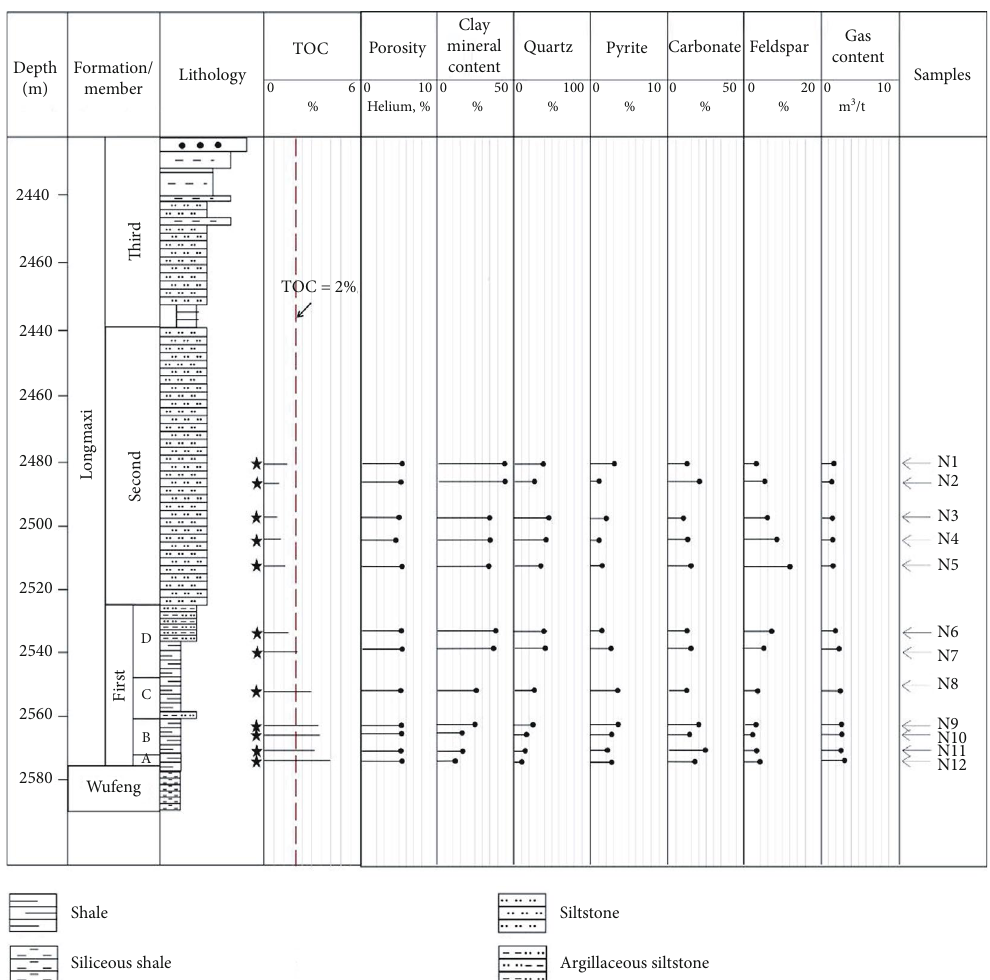
Figure 2: Compositional analysis, total organic carbon (TOC) content, helium porosity, and gas content of selected Wufeng-Longmaxi shale samples (N1 to N12) at di ff erent